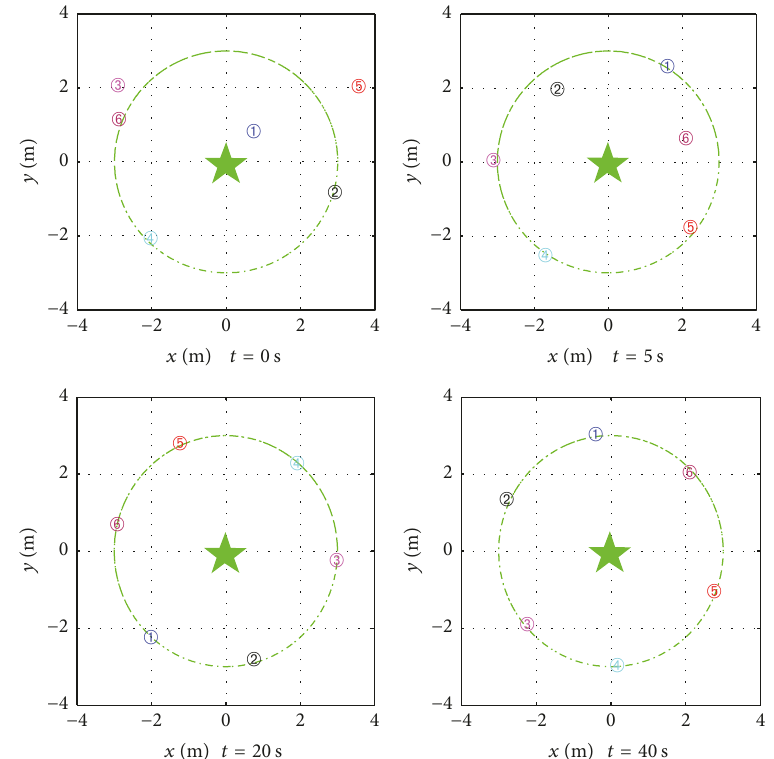
Figure 6: Position snapshots of the six agents in Case